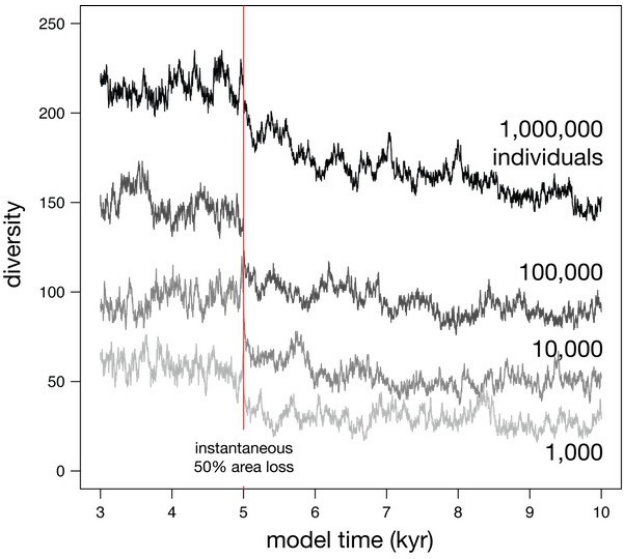
Figure 7. Four simulations showing the effect of metacommunity size (J before and after an instantaneous 50% habitat loss. The lower overall diversities compared to Figure 6 reflect the θ of 30 here, versus 300 in Figure